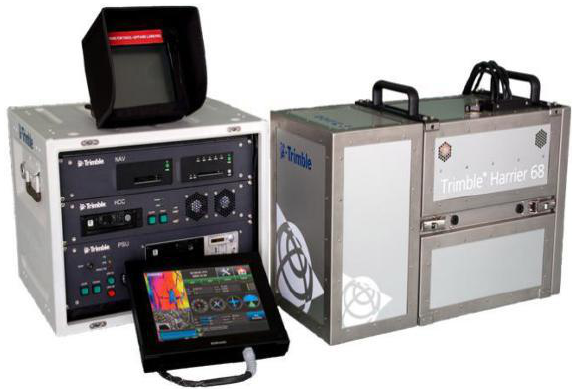
Figure 3. Harrier 68i LiDAR system